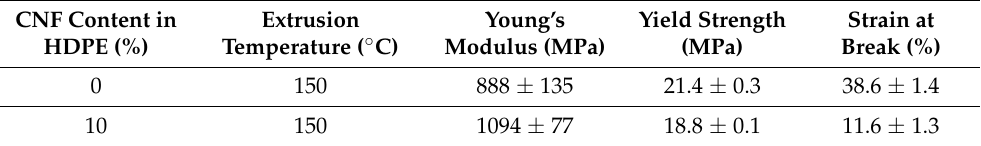
Figure 4. Experimental stress–strain curves of CNF-PSA/HDPE with neat HDPE; HDPE is repre- sented by the black curve and red for the composite. Stress–strain curves ( B ) are zoomed versions of ( A ). Table 1. Summary of the tensile properties of the HDPE and composite of 10 wt.% of CNF- PSA/HDPE.